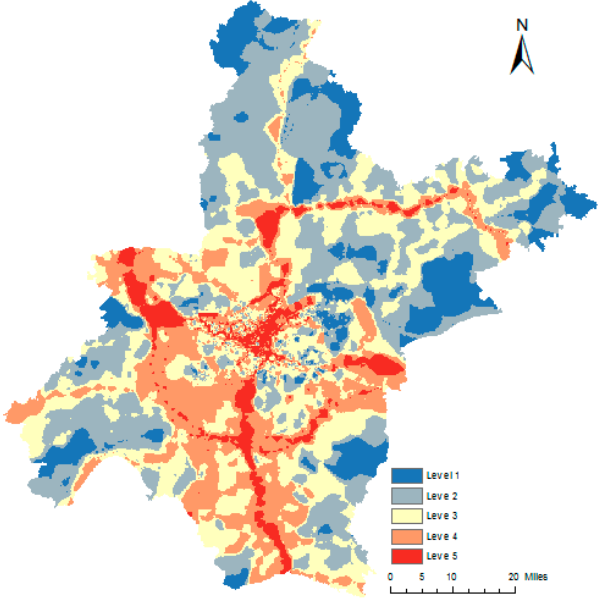
Figure 5. Integration level distribution map.